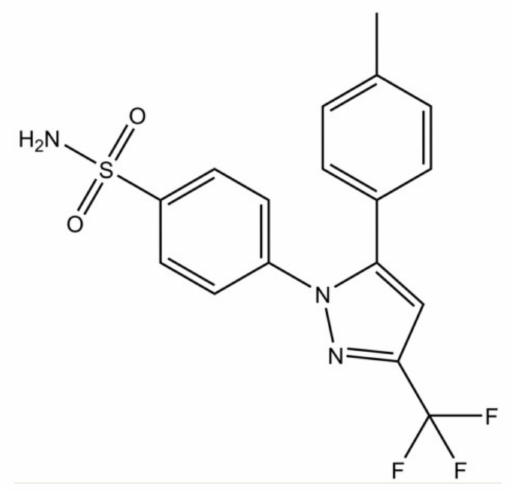
Figure 1. Chemical structure of